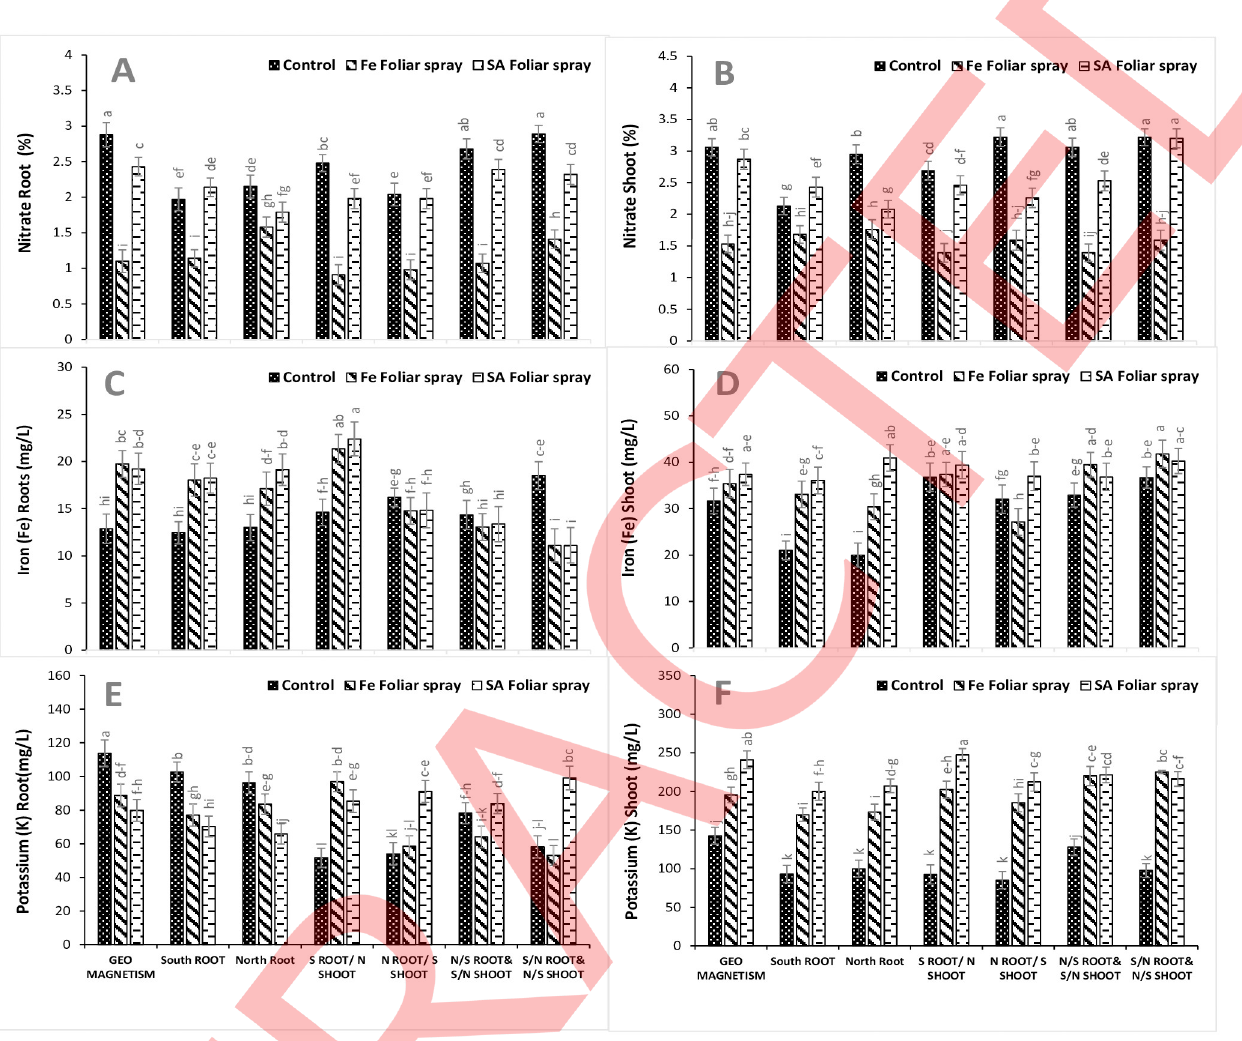
Fig 5. Effect of different magnetic treatments on the Nitrate Root (A), Shoot (B); Iron Root (C), Shoot (D), and Potassium Root (E), Shoot (F), content of Pisum sativum in response to Fe and SA Foliar Spray. The same letters on graphs represent statistically similar effect (P < 0.05).